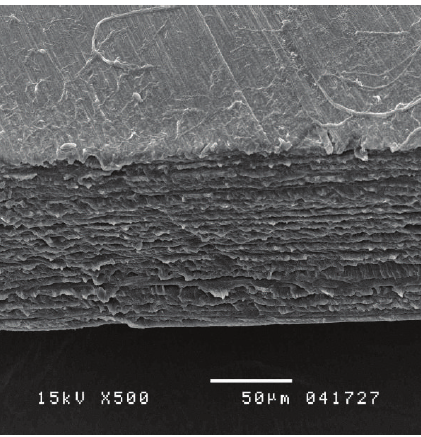
Figure 1: The multilayer arrangement of collagen within